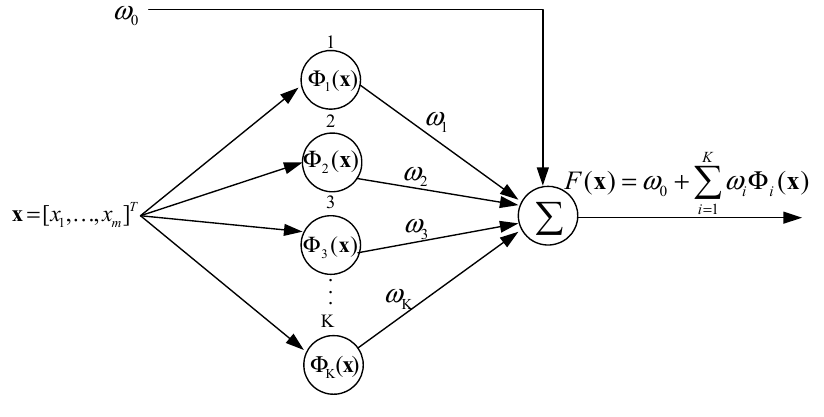
Figure 1. Framework of MARS.